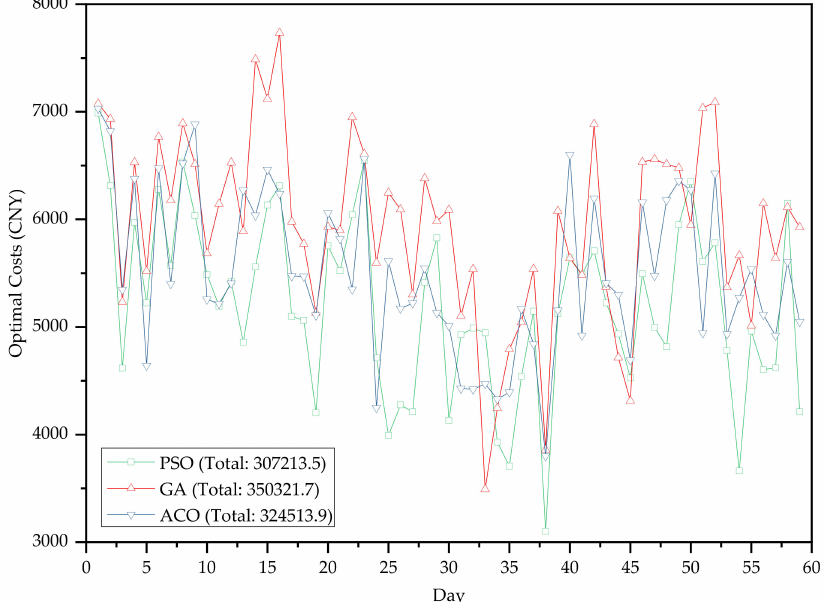
Figure A1. Comparison of optimal costs of the case system calculated by three algorithms (particle swarm optimization (PSO), genetic algorithm (GA) and ant colony optimization (ACO)) for 59 d from 22 June to 19 August